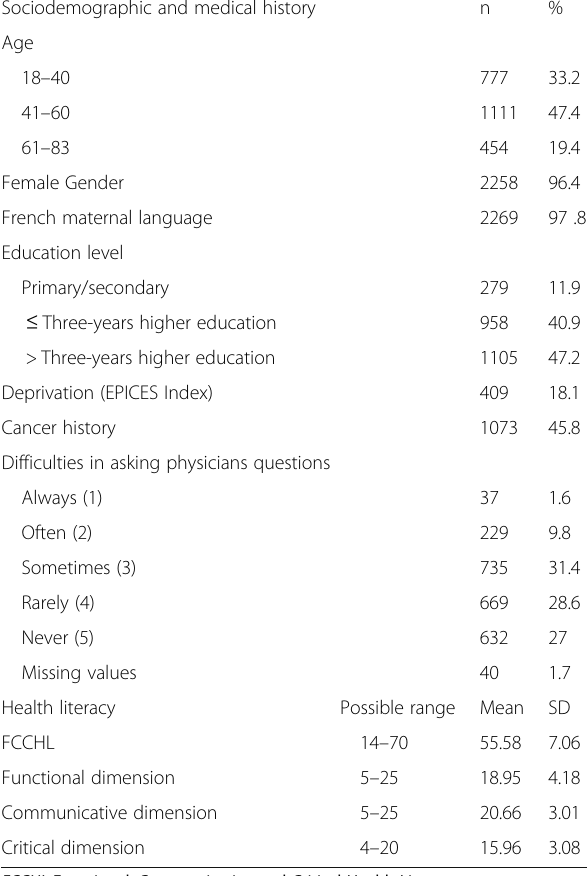
Table 1 Main participants ’ characteristics ( n = 2342) Sociodemographic and medical